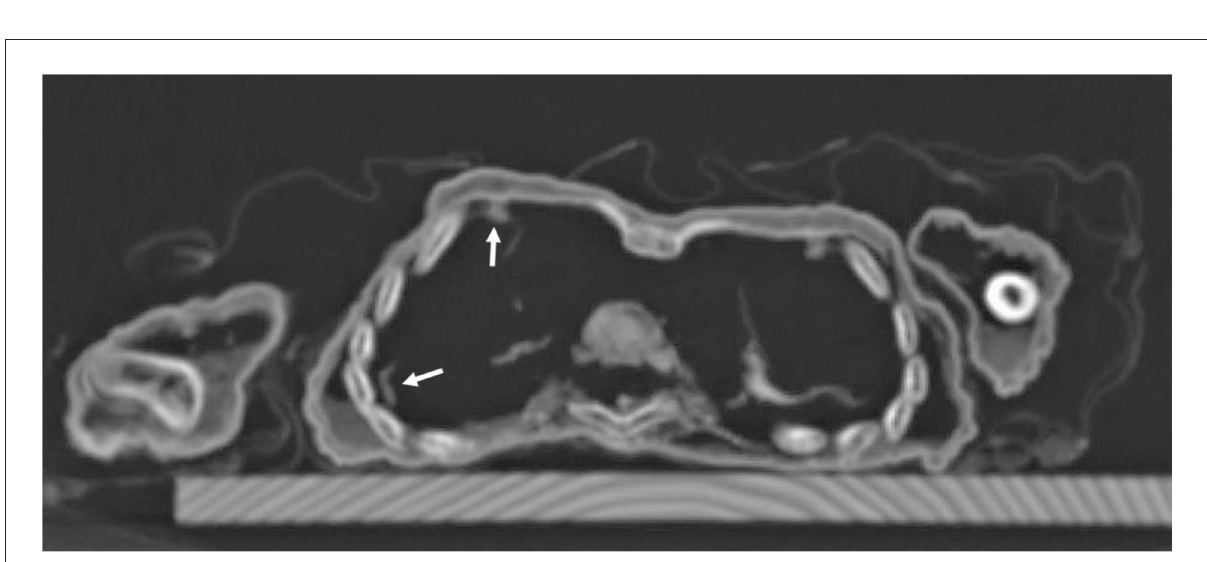
FIGURE9 Axial CT sections through the chest: besides the regular skeletal elements, there are remnants of lung tissue in the right chest cavity with some pleural adhesions (arrows).